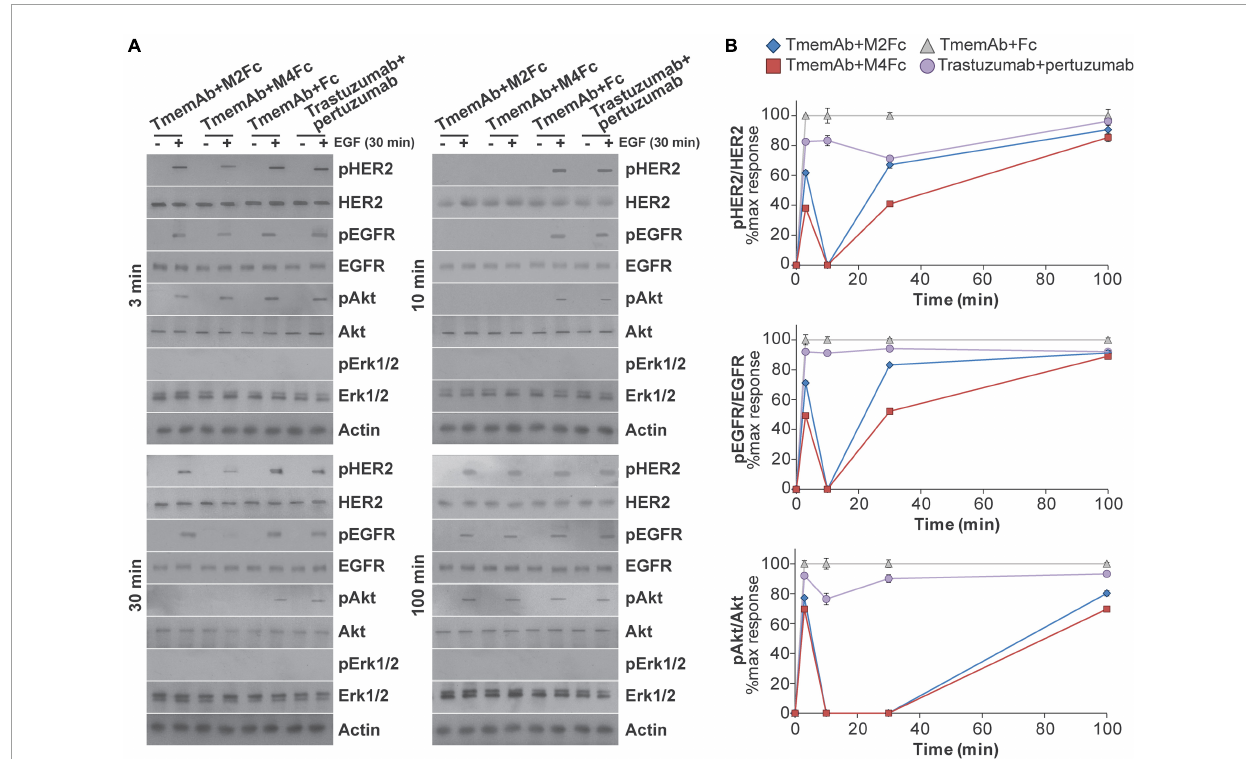
FIGURE4 Effects of multivalent meditopes on cell signaling pathways upon EGF stimulation of HER2-paGFP transfected MDA-MB-468 cells. Cells were treated with 10 nM trastuzumab memAb for 10 min, followed by either 10 nM Fc, M2Fc, M4Fc or Fc for indicated times. Cells were incubated for additional 30 min without or with addition of 10 ng/ml EGF. Alternatively, cells were co-treated with 10 nM trastuzumab and 10 nM pertuzumab for indicated periods of time. After brief wash with warm media, cells were incubated for additional 30 min without or with addition of 10 ng/ml EGF. All treatments were performed at 37 ◦ C; cells were briefly washed with warm media before and after treatment with Fc or Fc-meditope constructs. (A) Phosphorylation of EGFR(Y1068), HER2(Y877), and downstream signaling targets Akt(S473) and Erk1/2(p42/44 T202/Y204) was determined using Western blot analysis for cells treated as described above. (B) Relative phosphorylation of Akt, HER2, and EGFR for cells treated as described above was calculated as the ratio of pAkt over total Akt, pHER2 over total HER2 or pEGFR over total EGFR and normalized to the maximum response by Fc at the indicated time points. Results are representative of 5 independent experiments. Colors show Fc treatment in gray, M2Fc treatment in blue, M4Fc in red, and combined parental trastuzumab and pertuzumab in purple. M4Fc has the highest inhibition of EGF mediated